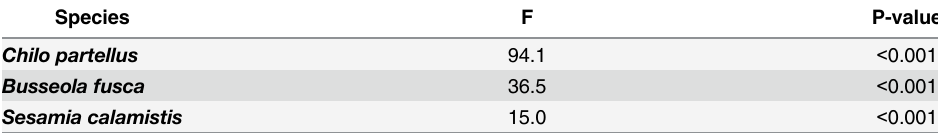
Table 2. Results of ANOVA comparing relative growth rates of each single-species at different con- stant temperatures.